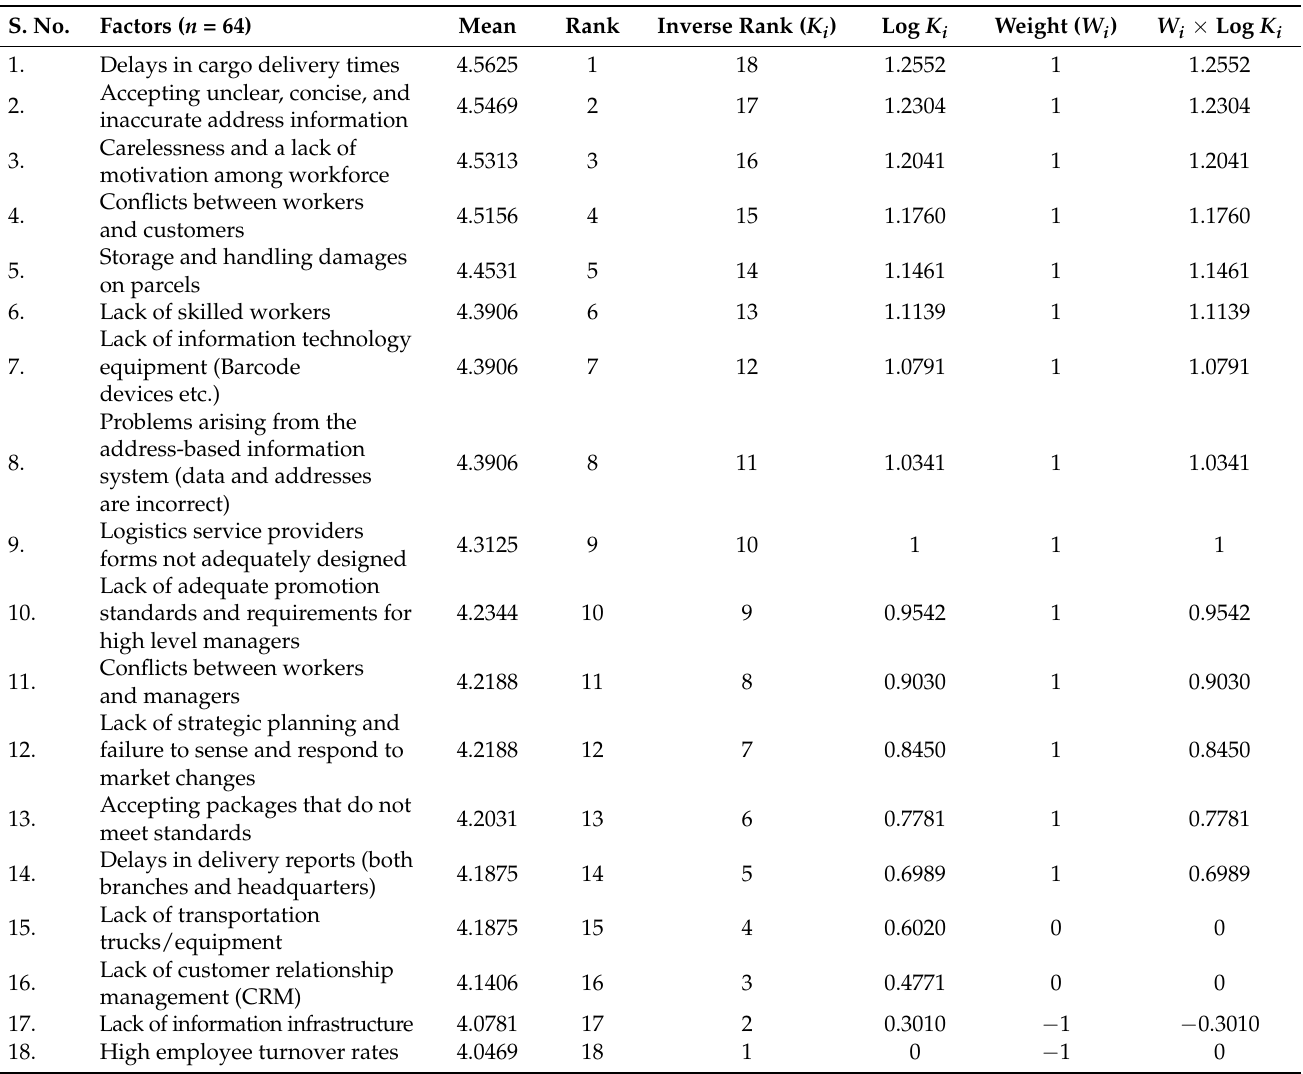
Table 2. Mean score, rank, and weighted measure of importance of selected